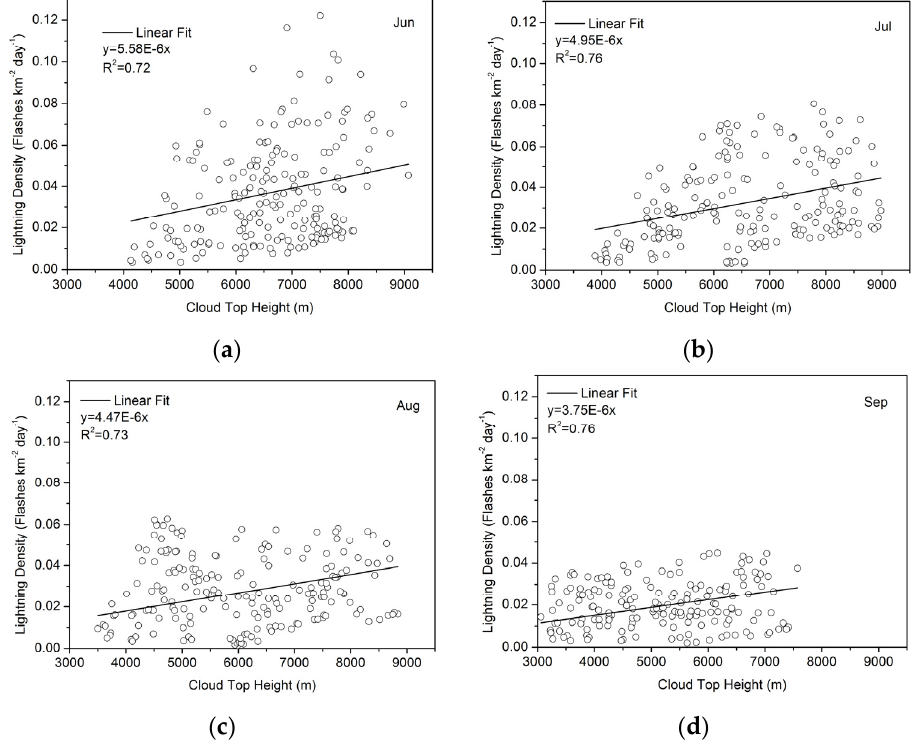
Figure 4 . Correlation between lightning flash density (flashes km − 2 ·year − 1 ) and cloud top height (m) Figure 4. Correlation between lightning flash density (flashes km − 2 · year − 1 ) and cloud top height (m) for June to September over China area . ( a ) June; ( b ) July; ( c ) August; ( d ) September. for June to September over China area. ( a ) June; ( b ) July; ( c ) August; ( d )